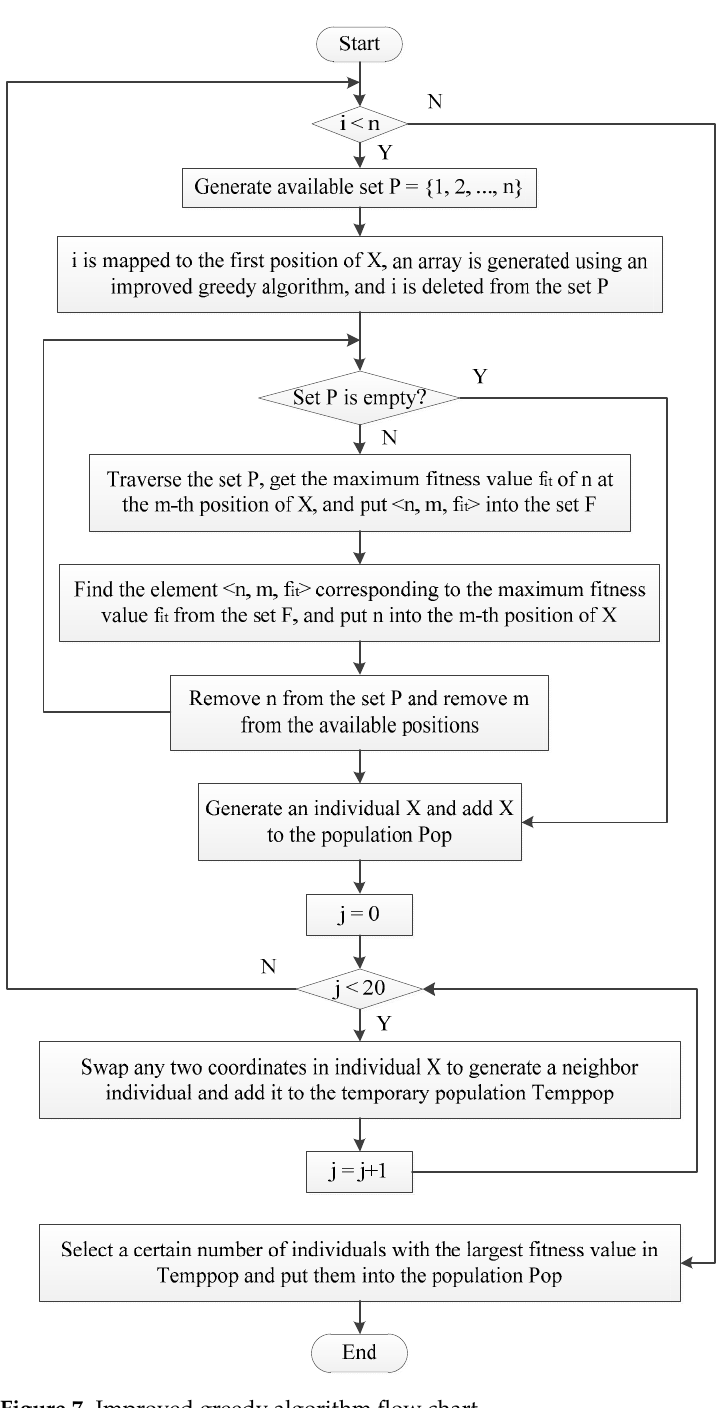
Figure 7. Improved greedy algorithm flow chart.